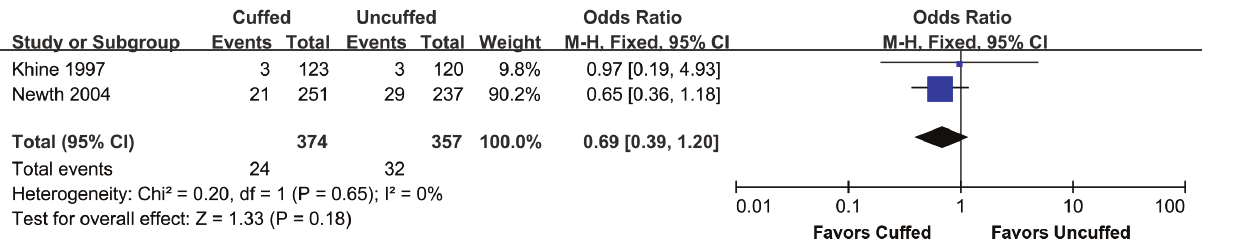
Supplemental Figure 4: The meta-analysis of racemic epinephrine use between cuffed and uncuffed